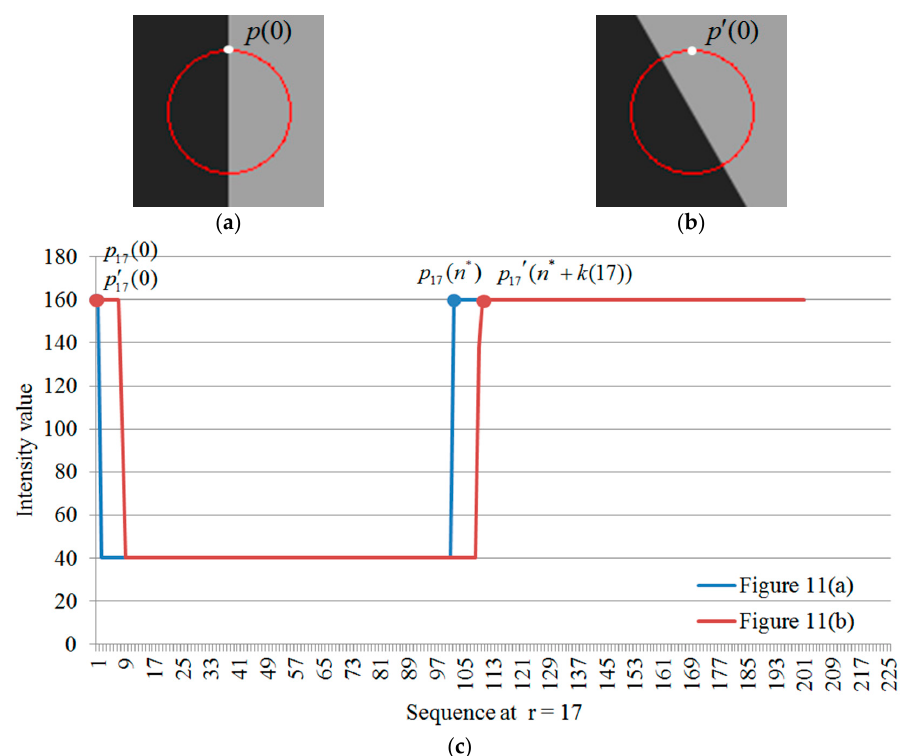
Figure 11. An example of the ring intensity profile at the specific radius (radius = 17). ( a ) Original image; ( b ) Rotated image (30°, CCW); ( c ) Shift point (17) k in the profiles with rotation angles.